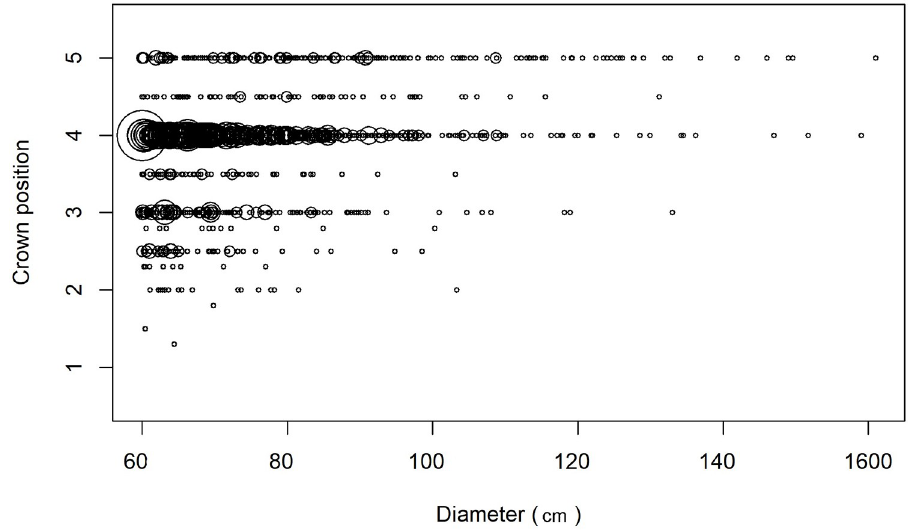
Fig 2. Large tree crown position by trunk diameter. Crown position, an index of exposure to illumination [25], of 1622 large trees in 238 0.5 ha plots across an upland old-growth tropical rain forest landscape at the La Selva Biological Station, Costa Rica. Crown position codes: 5 = fully emergent (exposed to both lateral and overhead light), 4 = � 90% of crown exposed to vertical illumination; 3 = 10–90% vertical illumination; 2 = only lateral illumination, 1 = no direct illumination. Crown position was evaluated by two observers, and the average of the two estimates was calculated for each tree. Symbol size is proportional to the square root of the number of observations (range = 1–27).